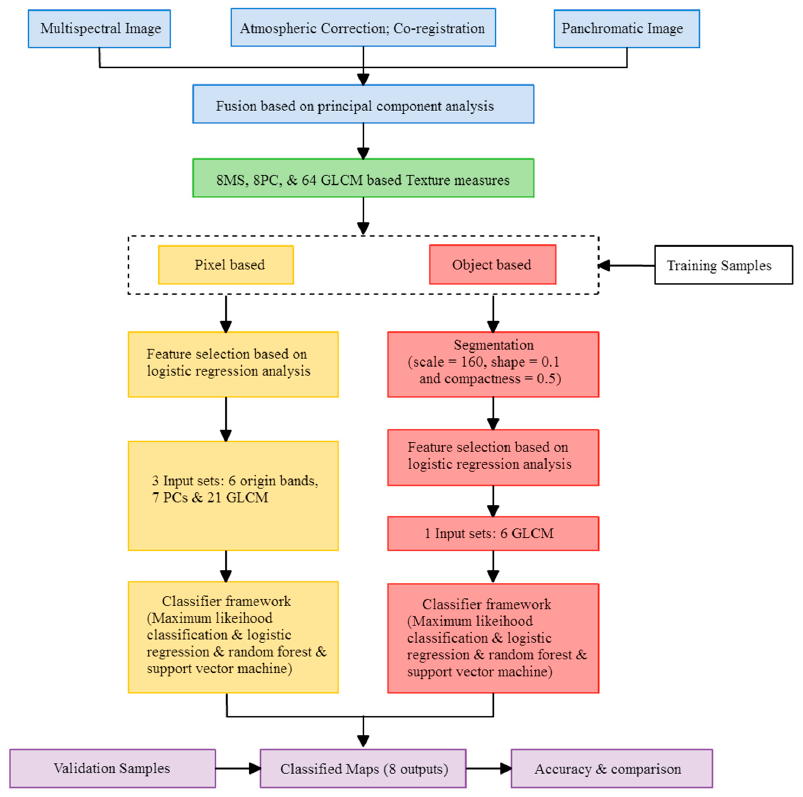
Figure 2. Methodological flowchart for mapping tea cultivation area.